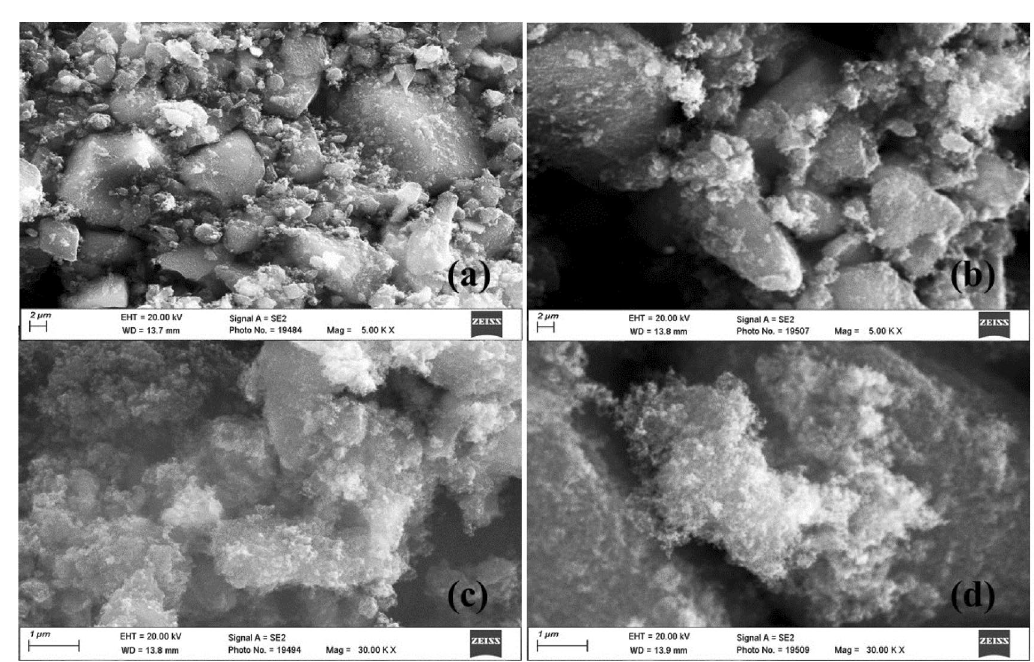
Fig. 2 SEM images for gels prepared with sodium carbonate (RF) and lithium perrhenate (RF LiRe)